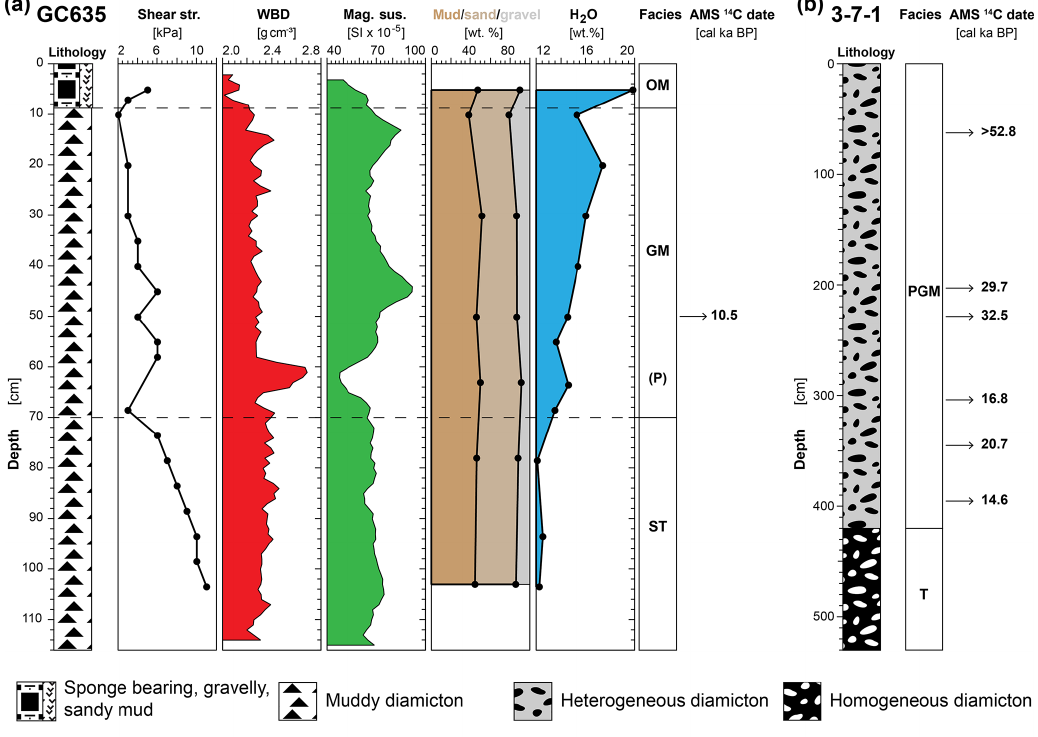
Figure 8. Sedimentological parameters and radiocarbon ages from cores in the study area (for the location, see Fig. 2): (a) lithology, shear strength (str.), wet bulk density (WBD), magnetic susceptibility (mag. sus.), grain size composition of the sediment matrix, water content (H 2 O), facies interpretation, and AMS 14 C ages of core GC635 (this study) and (b) lithology and AMS 14 C ages of core 3-7-1 (modified from Stolldorf et al., 2012). For the given ages, see Table